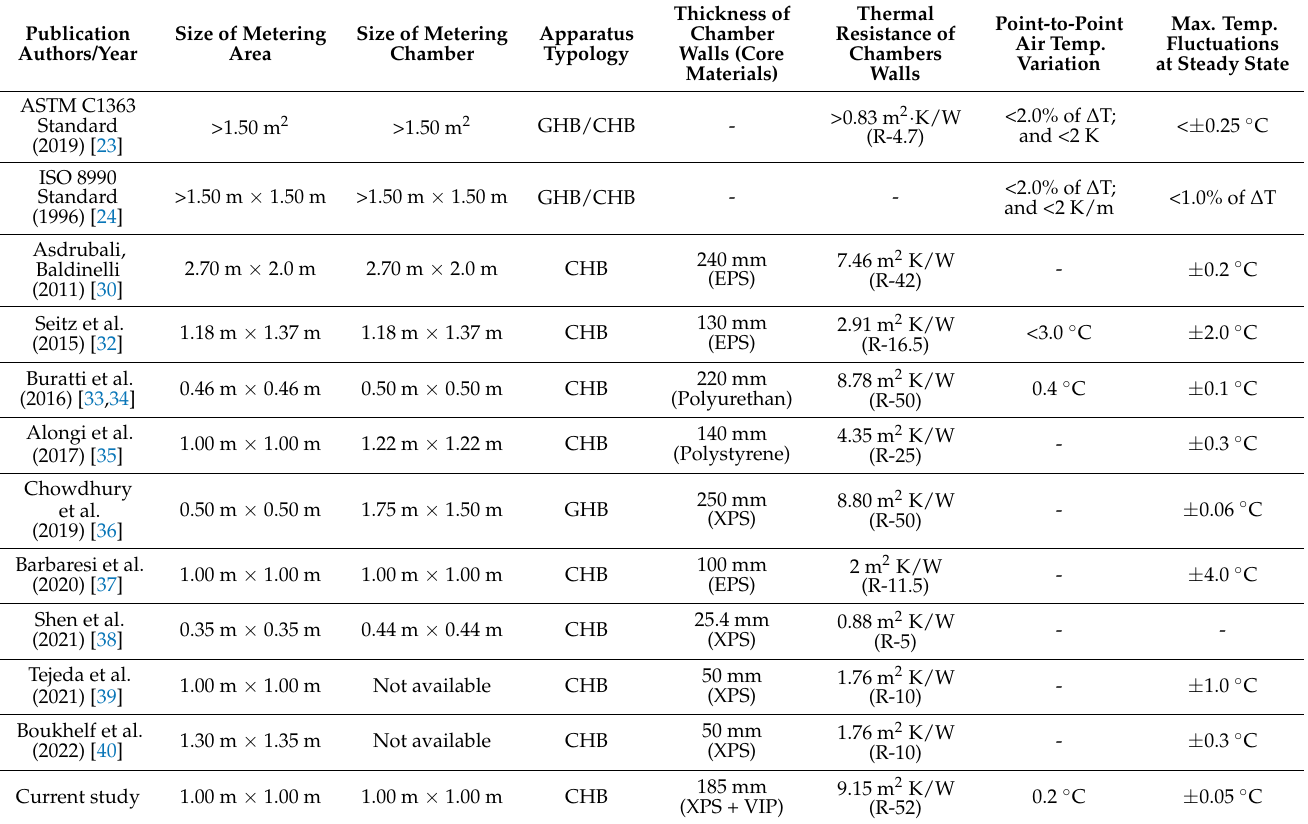
Table 1. Detailed description of selected studies utilizing comparable test